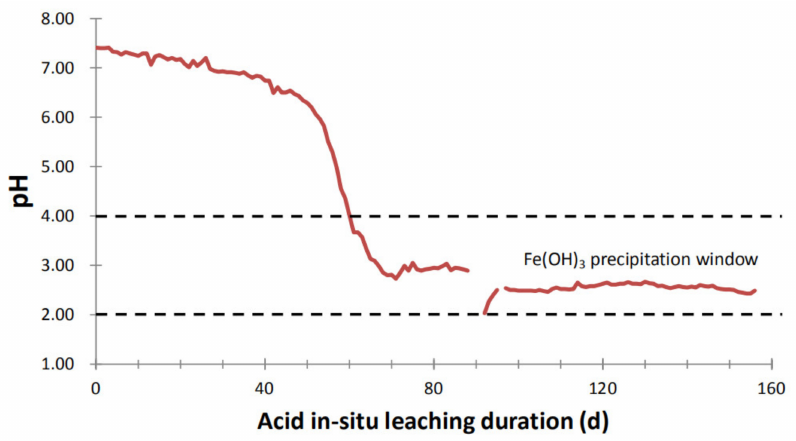
Figure 7. Variation of pH value of leaching solutions from the acid ISL mine (modified from